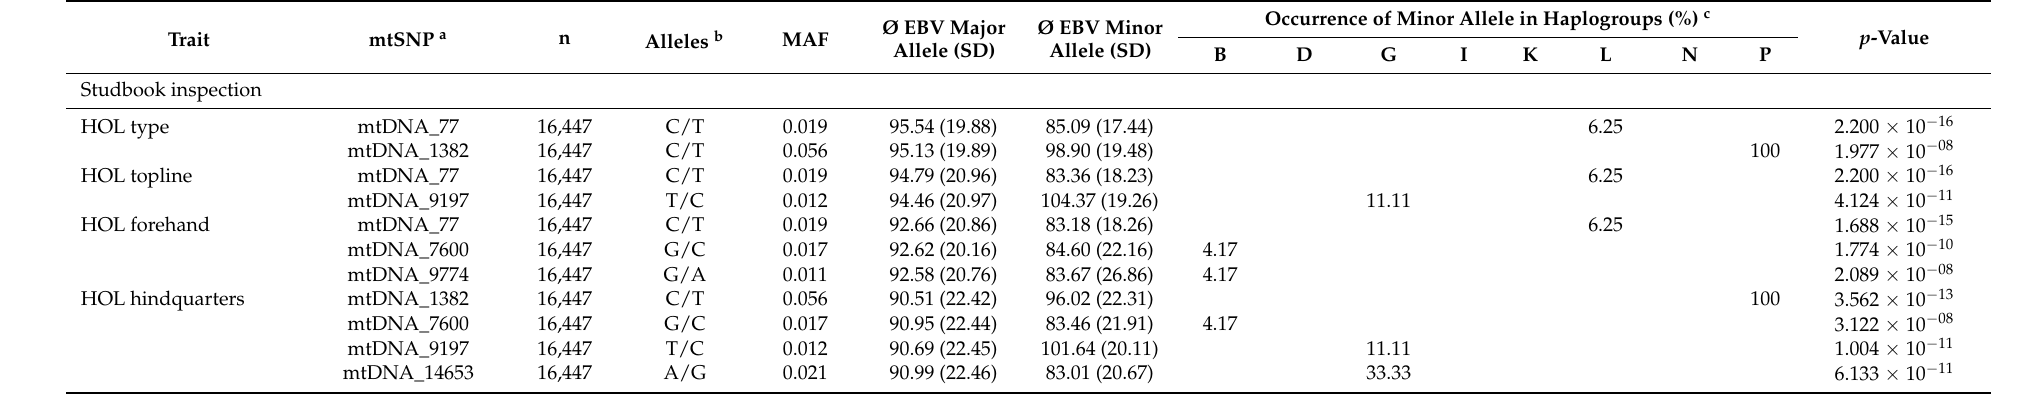
Table A2. Results for the association between breeding values (EBV) for studbook inspection, mare performance test and significant mitochondrial SNPs ( p < 5 × 10 − 8 ), average breeding values for the two alleles, and distribution of the minor allele among